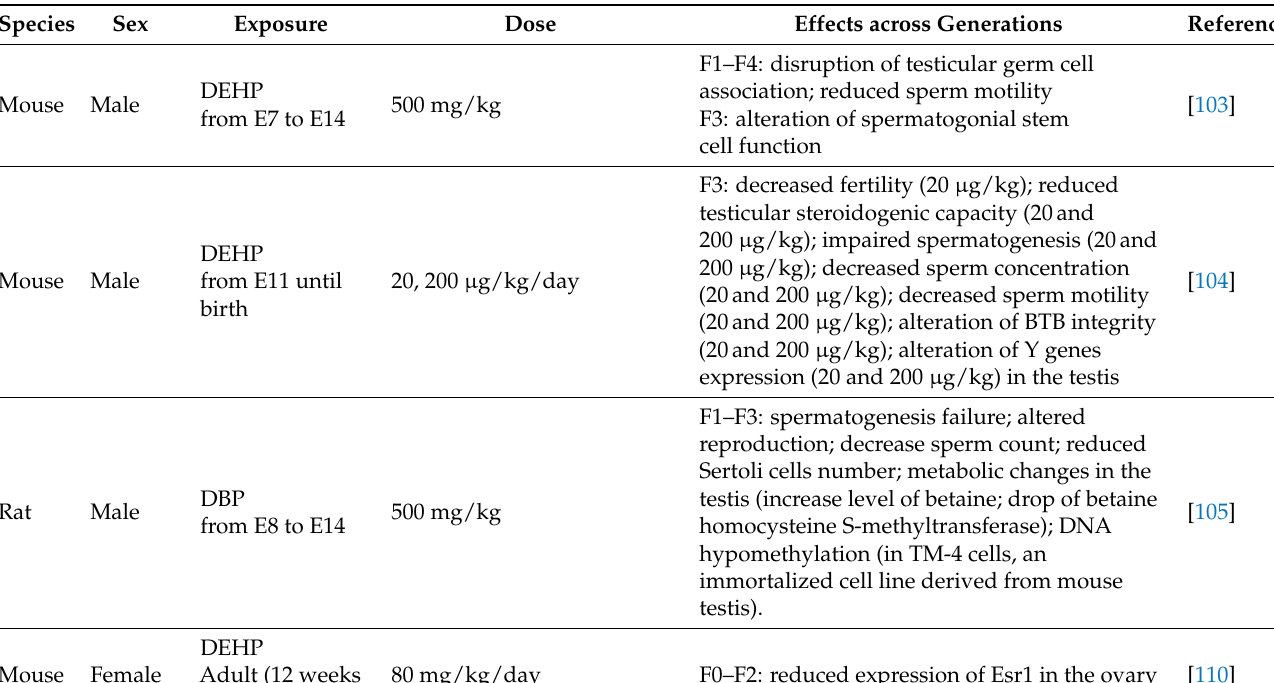
Table 3. Phthalate-induced effects in model animals across